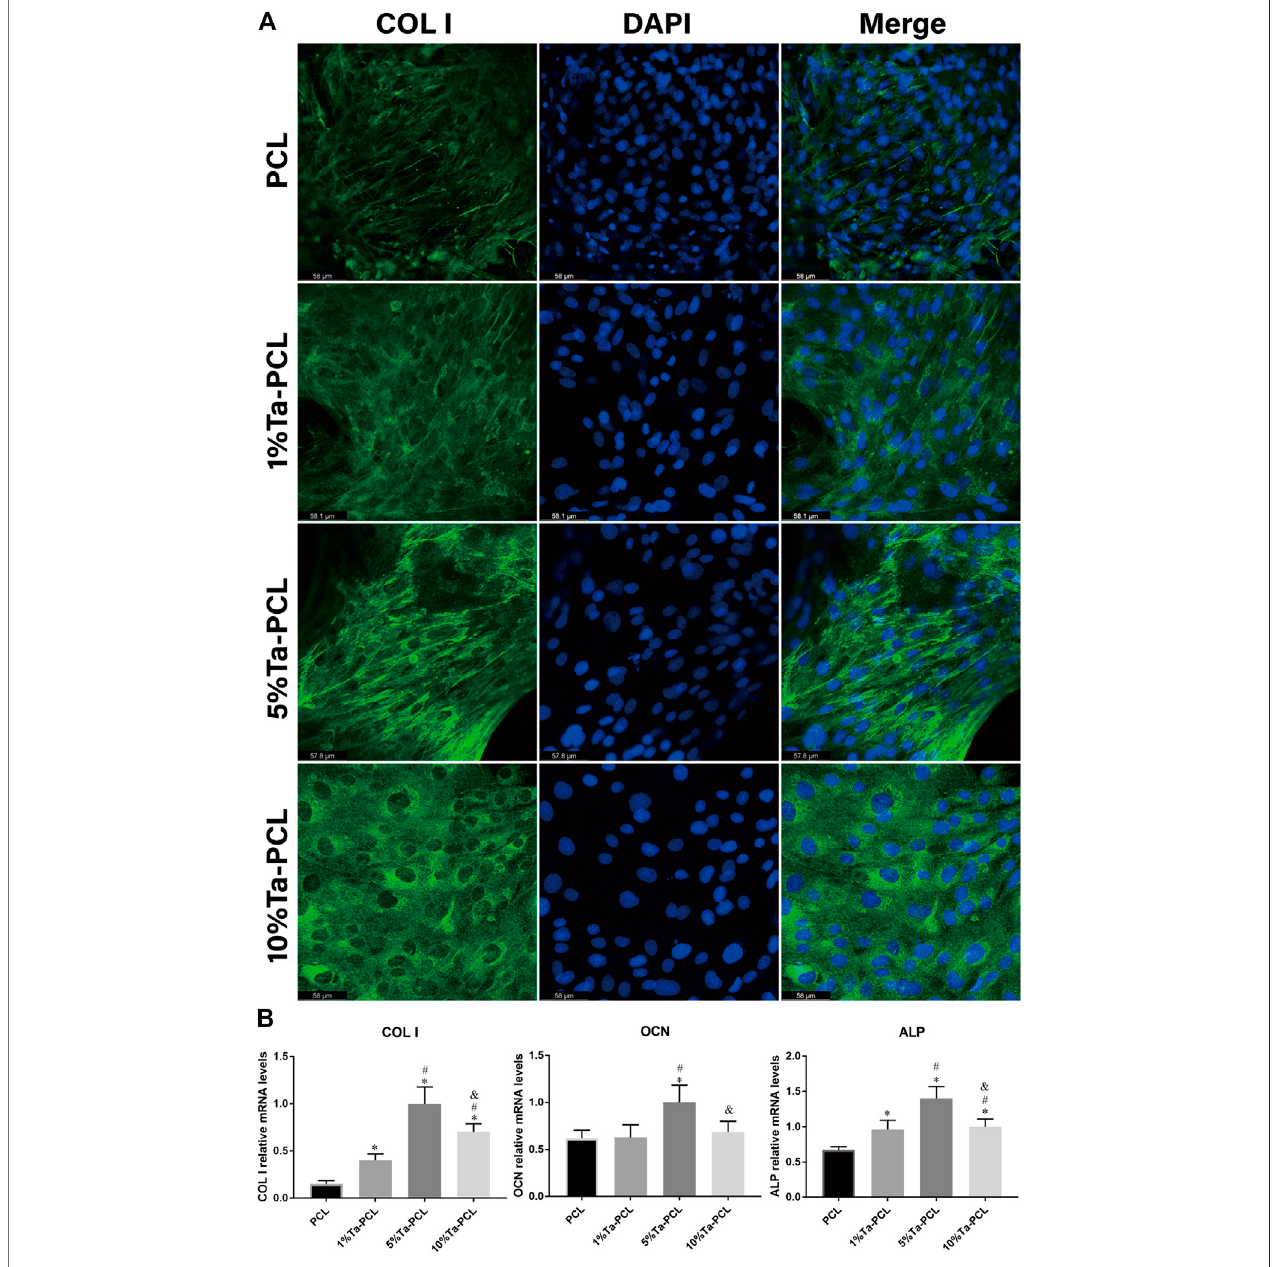
FIGURE5| OsteogenesisofTa/PCL (A) COLIstaining. (B) OsteogenesisrelatedgeneexpressionanalyzedbyqPCR.* p < 0.05vs.PCL;# p < 0.05vs.1%Ta-PCL; & p < 0.05 vs. 5% Ta-PCL.